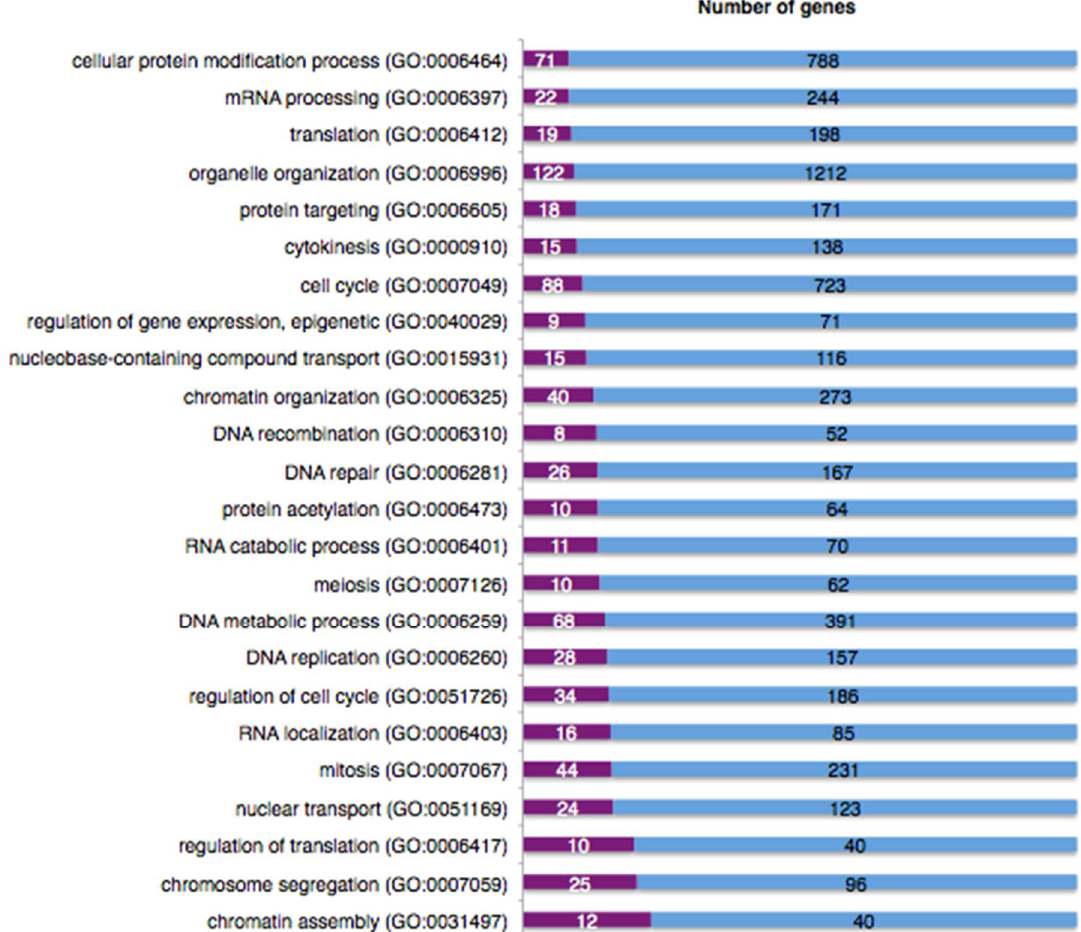
Figure 6. The DNA damage response affects mRNA levels of cellular genes with various biological functions, including genes encoding mRNA processing factors. Total RNA was harvested from HPV16 reporter cell line C33A2 after induction of the DNA damage response with 100 µ M melphalan for 22 h. The RNA samples obtained from DMSO- or melphalan-treated C33A2 cells were